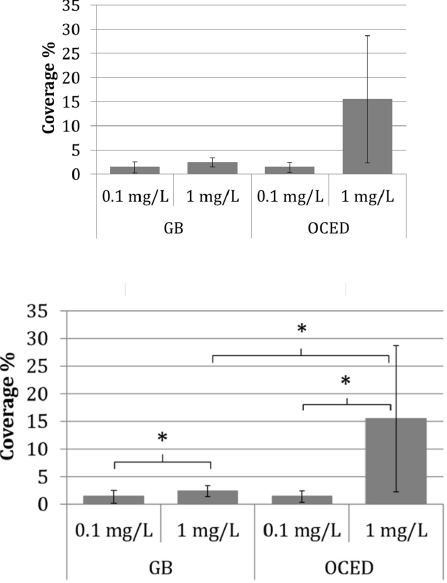
Figure 6. Coverage of the algal surface with cerium from NM-212 particles as determined by SEM-EDX image overlay analysis. We analyzed 5–6 samples per medium (GB and OECD), each sample comprised 2–7 cells. The data are means ± standard deviations. One-tailed unpaired t -test (Microsoft Excel 2013) revealed significant di ff erences (marked by *) between the concentrations ( p = 0.033 in GB medium, p = 0.044 in OECD medium) as well as between the media at 1 mg / L ( p =